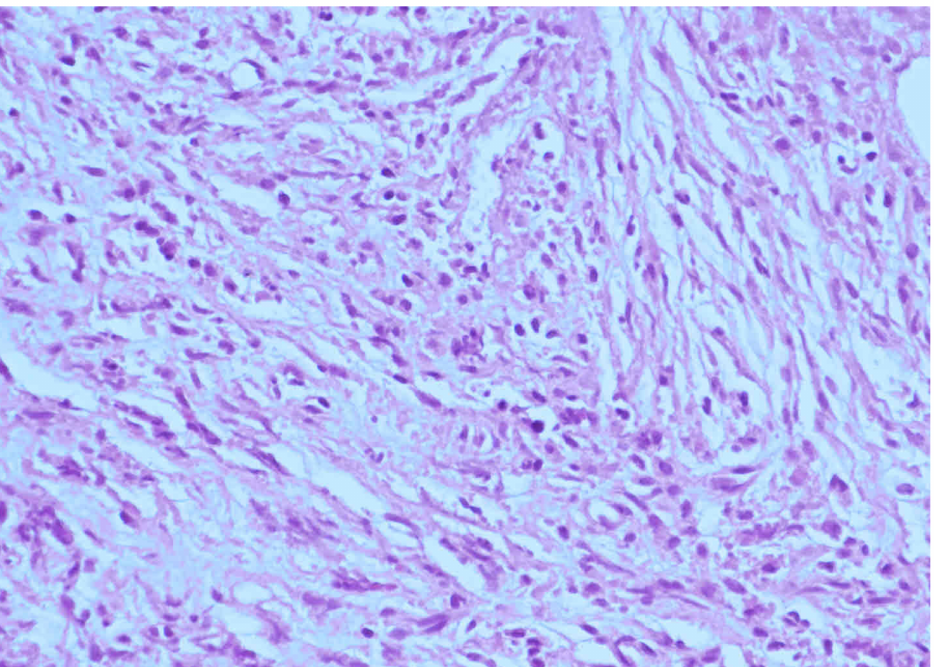
Figure 3. Histological section of the surgical specimen showing acute and chronic inflammatory changes, including inflammatory cells with fibrosis (hematoxylin and eosin staining, original magni- fication 400 × ). A diagnosis of an inflammatory pseudotumor (IPT) was made.